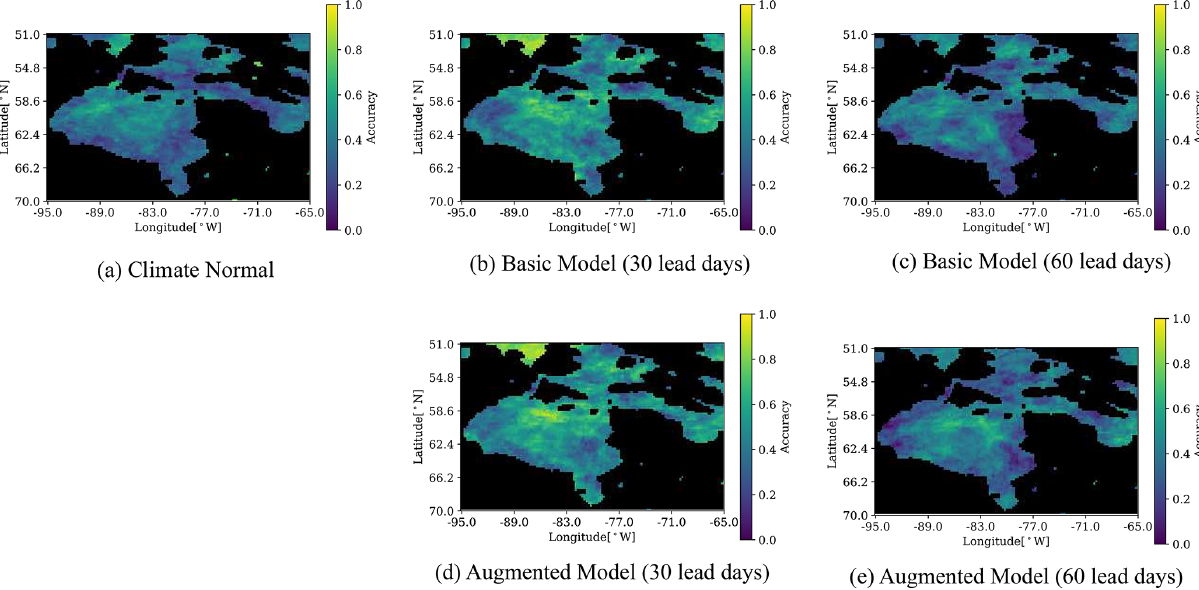
Figure 9. Accuracy of the predicted breakup date within 7d. Breakup dates are checked from 1 May to 31 July. The 7d window is chosen to match to the definition used by the Canadian Ice